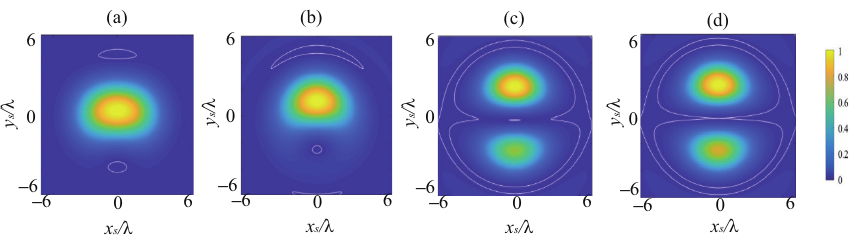
Figure 10. The longitudinal energy flow S z on the xOy -plane, where ( a ) σ c = 0.2, ( b ) σ c = 0.8, ( c ) σ c = 10 and ( d ) σ c = 15. In all plots, a = 0.5 w 0 , f = 2 mm, w 0 = 2 mm and α = 60 ◦ .